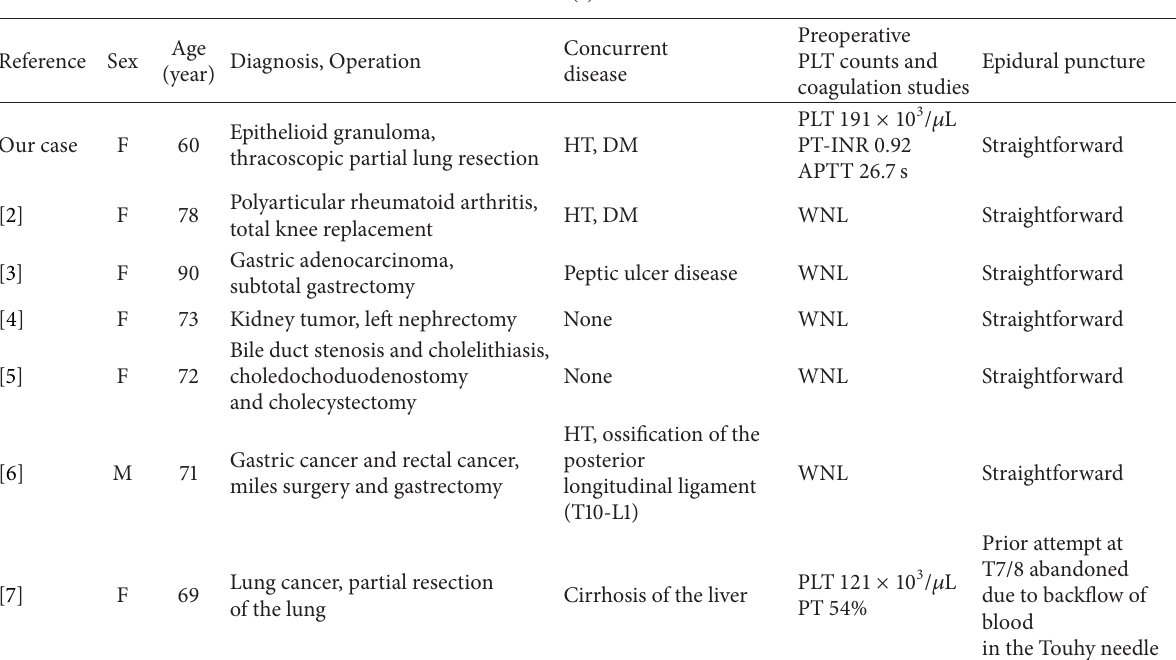
Table 1: Characteristics of patients with spontaneous recovery of paraplegia due to SEH associated with epidural